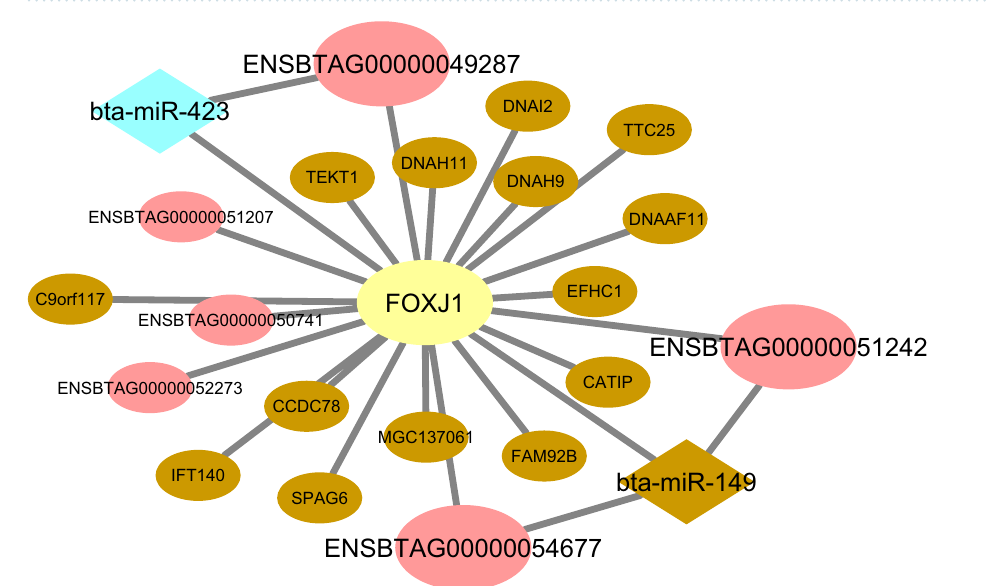
Figure 12. The constructed integrated regulatory sub-network related to FOXJ1 in brown Rb-module. The pink circles indicate hub-hub lncRNAs related to the mentioned gene. The brown and blue diamond represents miRNAs that be predicted to regulate FOXJ1 . Cytoscape software (version 3.7.2) (https:// cytos cape. org/) was used to generate this